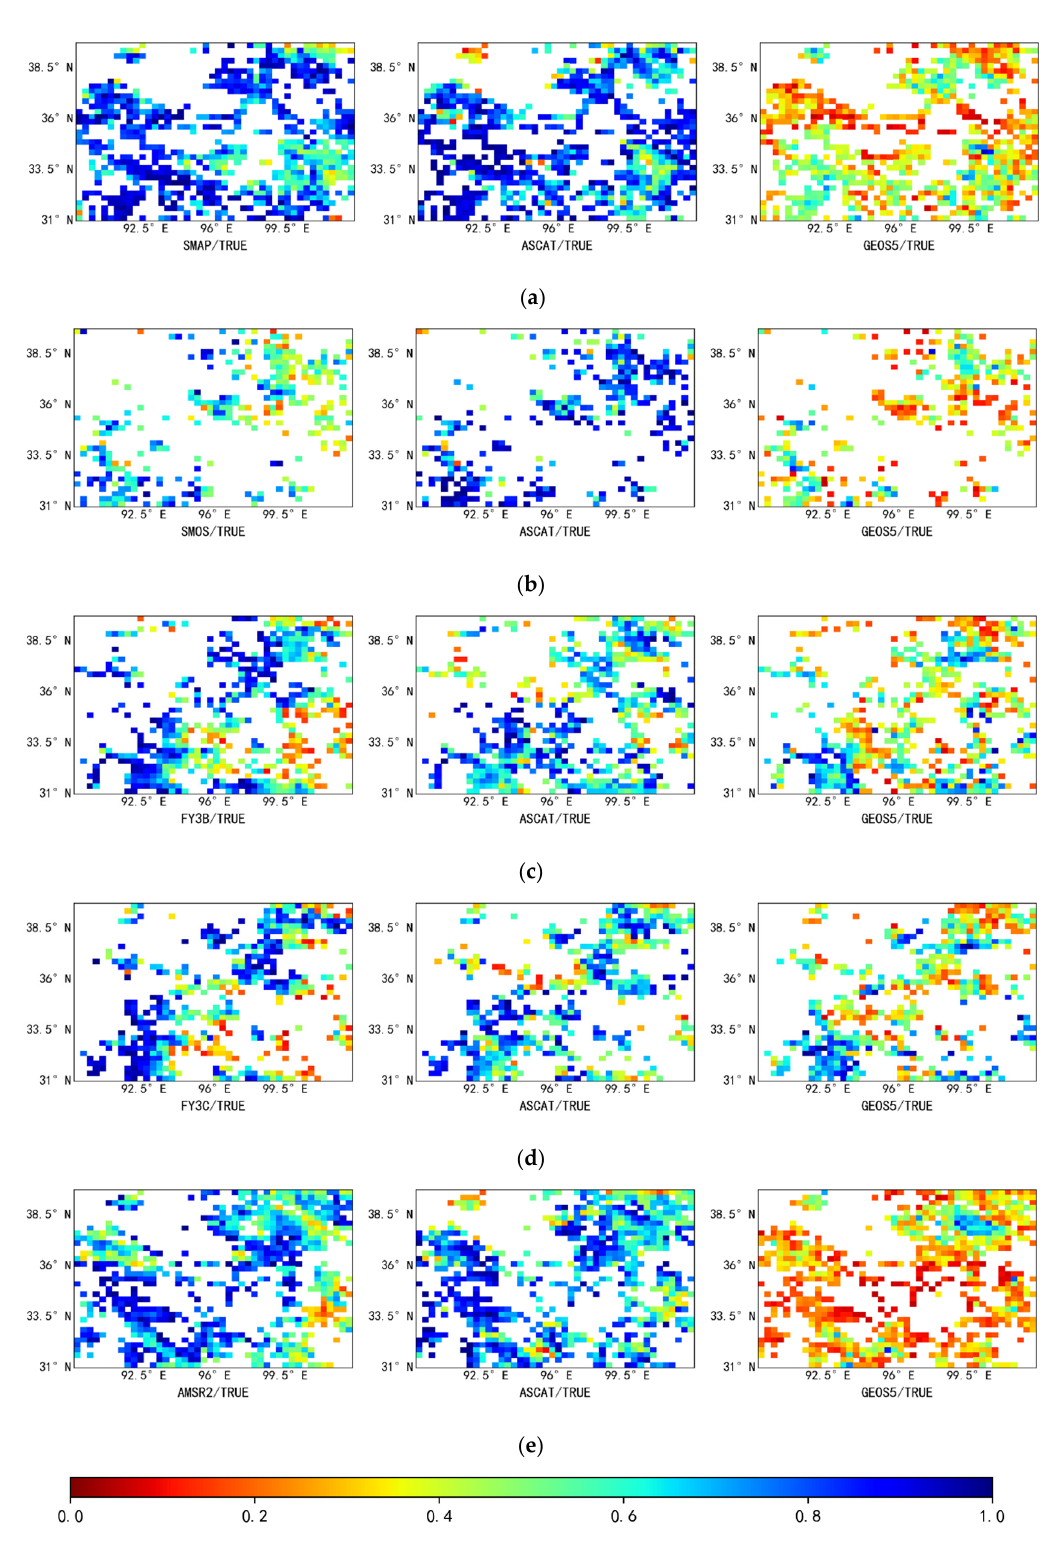
Figure 8. Spatial characteristics of the correlation coefficient (R) in the study area. The five columns of sub-figures show, from top to bottom: ( a ) [SMAP, ASCAT, GEOS5]; ( b ) [SMOS, ASCAT, GEOS5]; ( c ) [FY3B, ASCAT, GEOS5]; ( d ) [FY3C, ASCAT, GEOS5]; ( e ) [AMSR2, ASCAT, GEOS5]. The three rows of sub-figures show, from left to right, the correlation coefficients between the passive and true soil moisture, the correlation coefficients between the active and true soil moisture, and the correlation coefficients between the reanalysis and true soil moisture.